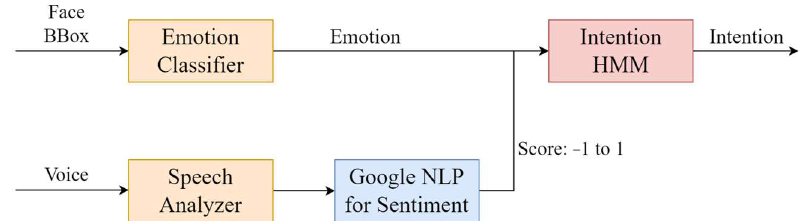
Figure 4. The architecture of the intention model.